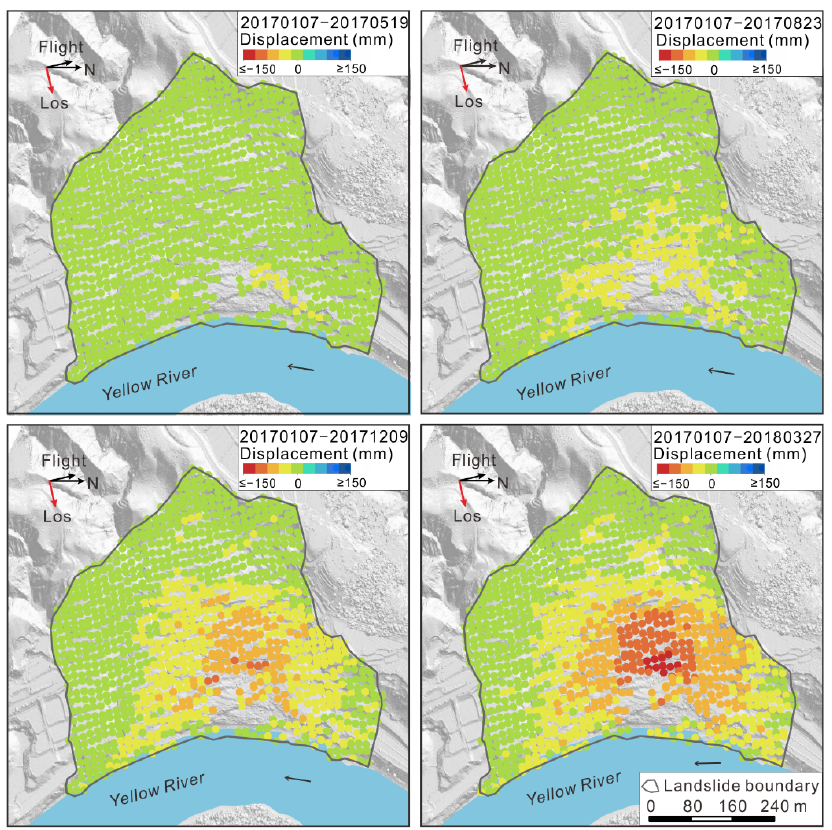
Figure 7. Pre-failure cumulative LOS displacement.